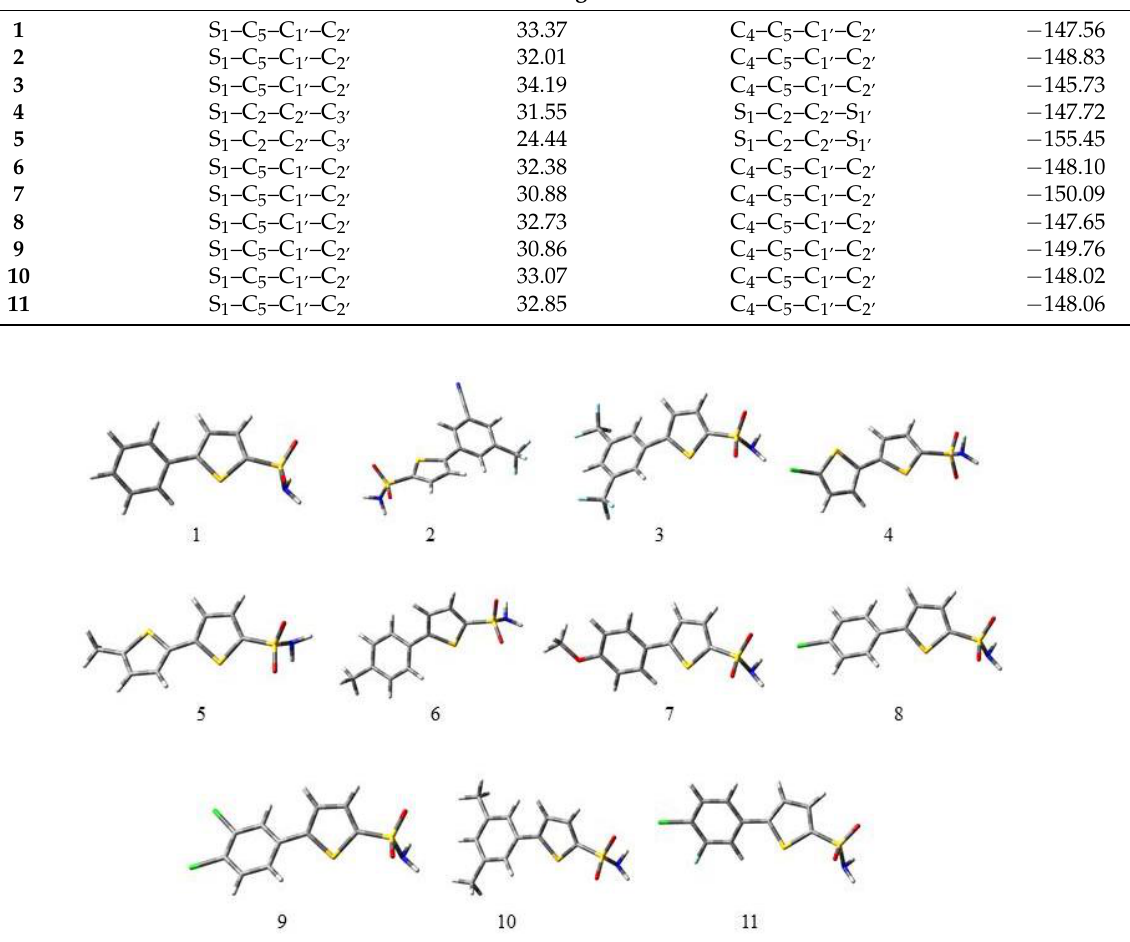
Figure 1. Optimized geometries of all the derivatives ( 1 to 11 ) under study at the B3LYP/6-311G (d,p)/SMD 1,4-dioxane level of theory. In 3D models, the grey color symbolizes carbon, white symbolizes hydrogen, the red color is for oxygen, green is for chlorine, the yellow color symbolizes sulfur, and the light blue color indicates fluorine. Table 1. Bond length Å of selected bonds of 1 to 11 .